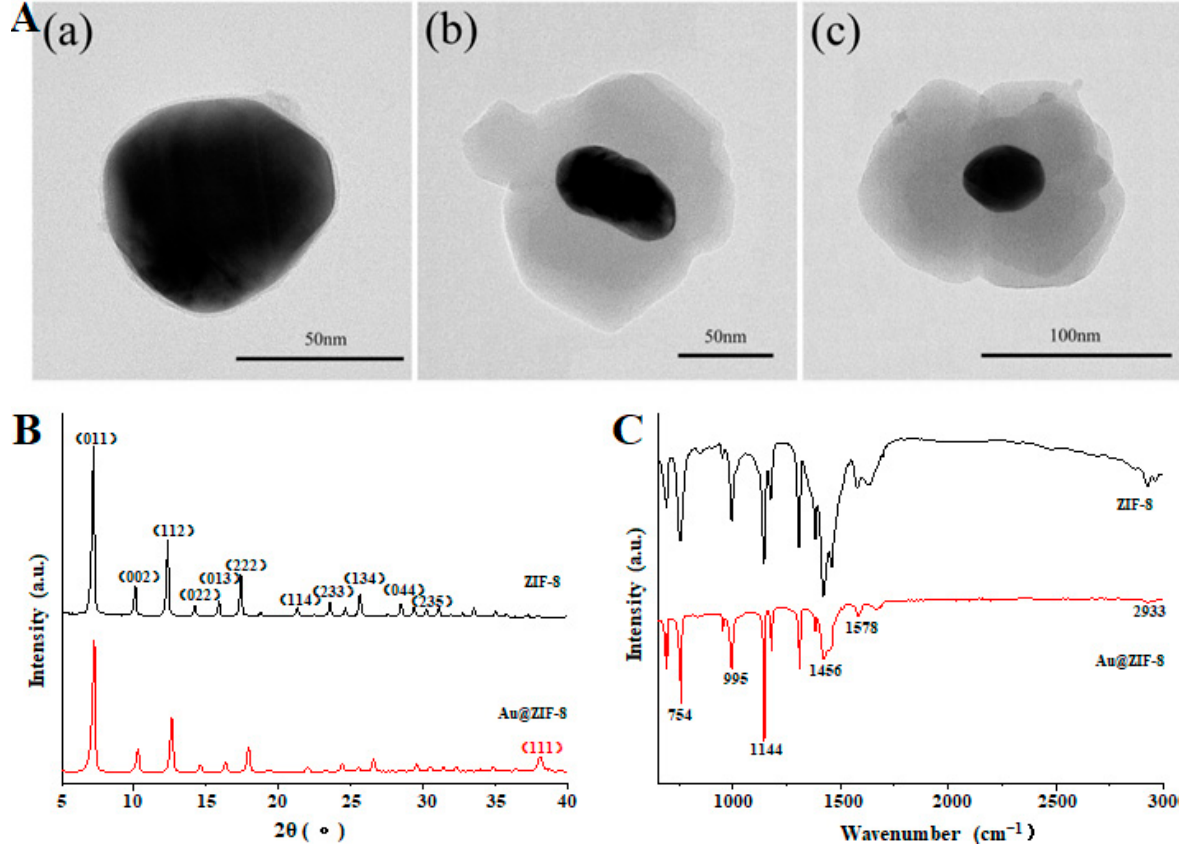
Figure 2. ( A ) TEM of synthesized ZIF-8 and Au@ZIF-8 (( a ) 3 nm, ( b ) 20 nm, and ( c ) 50 nm Au@ZIF-8); ( B ) XRD and ( C ) FT-IR pattern of synthesized ZIF-8 and Au@ZIF-8.